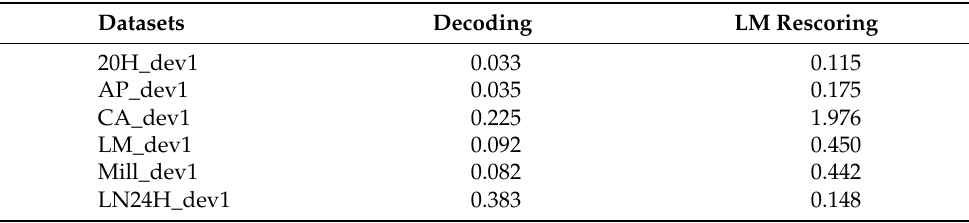
Table 4. Real-Time factor (RT) for the different stages carried out in the PyChain-based baseline according to the different